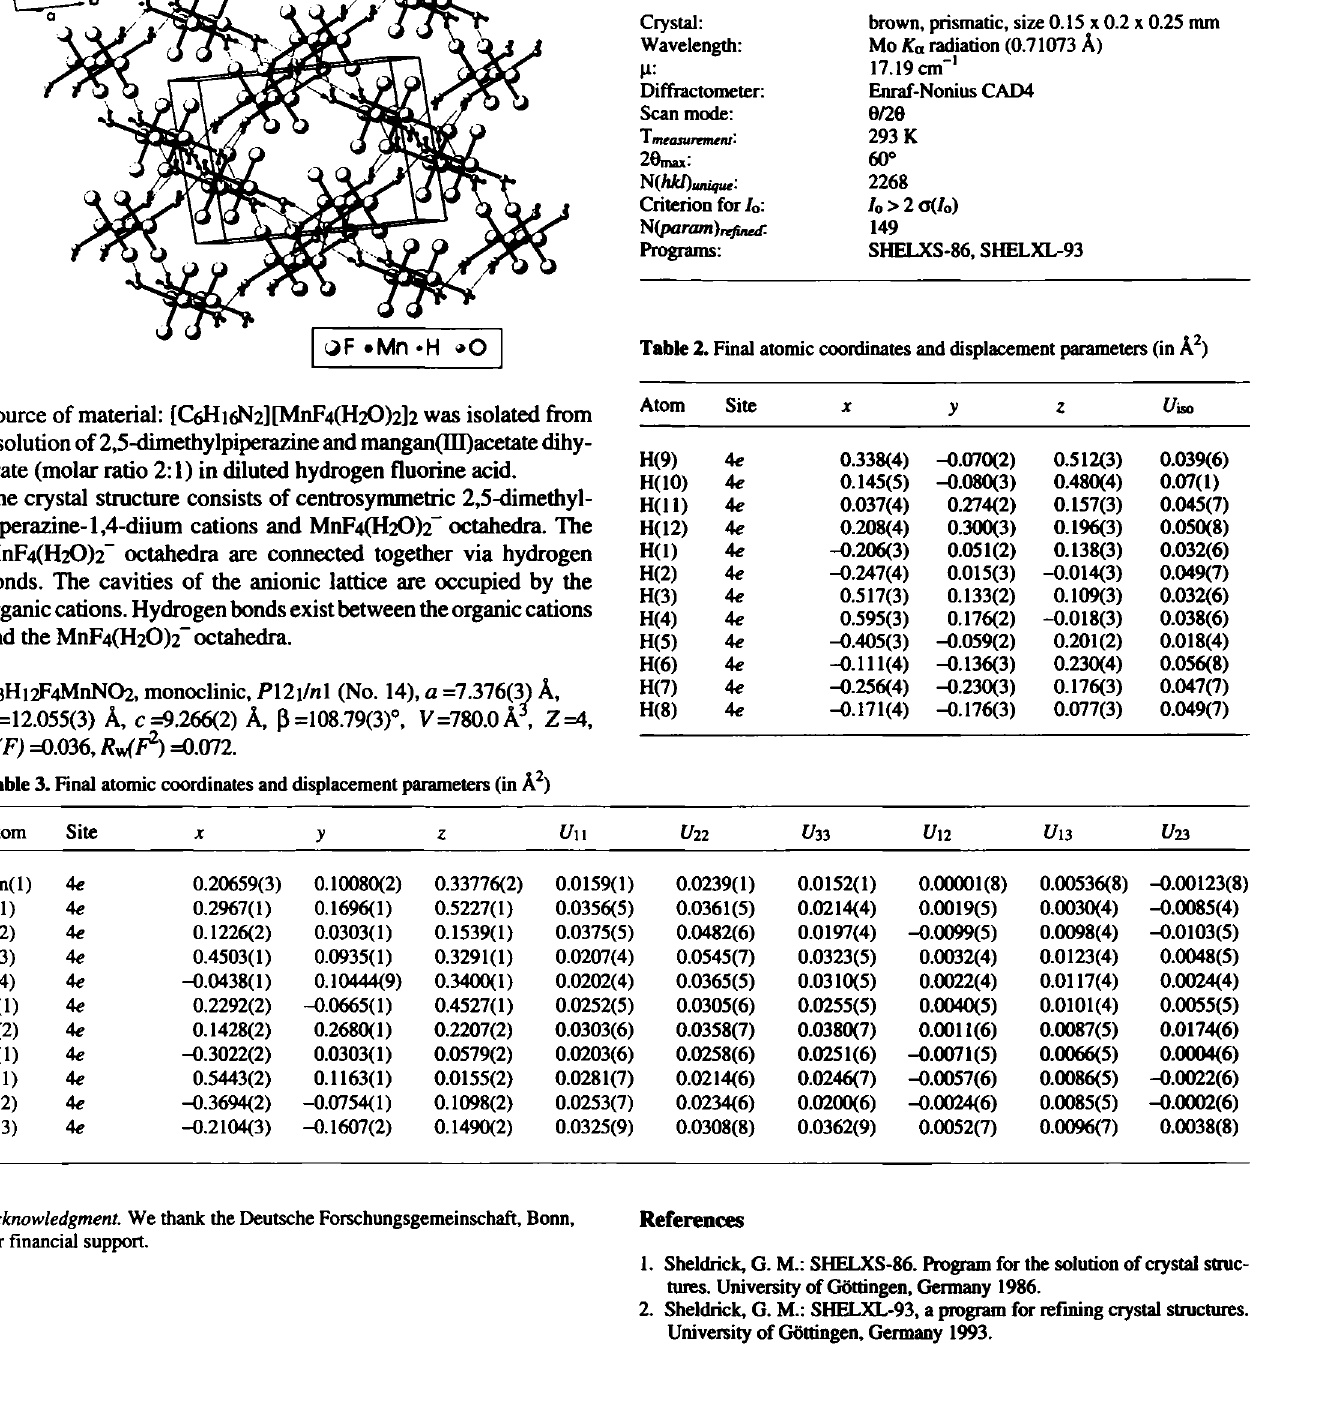
Table 1. Parameters used for the X-ray data collection